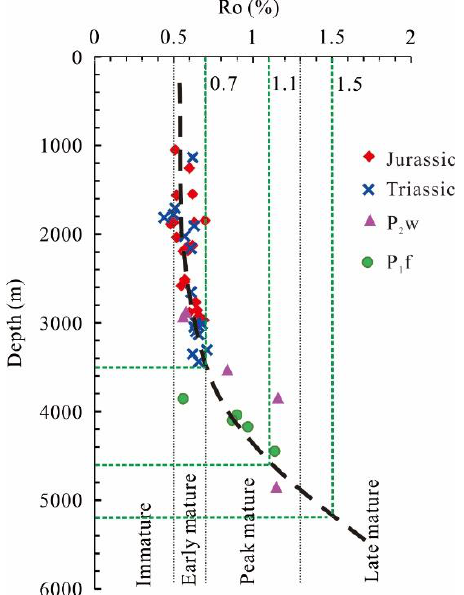
Figure 6. Variation in Ro with depth of source rock in the Mahu Sag.